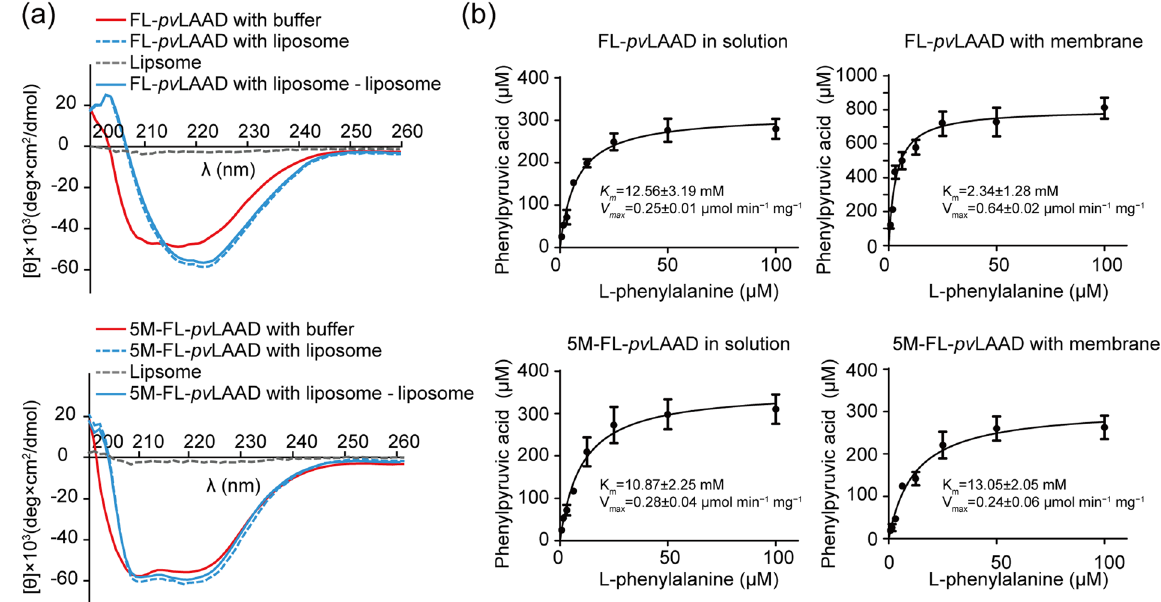
Figure 4. Membrane binding stabilized the structure of pv LAAD. ( a ) Liposome-binding-caused secondary structure changes of the wild-type and mutated pv LAAD were detected by CD. The CD spectra of FL- pv LAAD and 5M-FL- pv LAAD were recorded with or without adding the liposome. The CD spectrum of the liposome was also recorded (dashed line), and was subtracted as background from the spectra of pv LAADs with the liposome. An obvious bathochromic shift was observed between the CD spectra in solution (Red line) and with liposome (Blue line) of FL- pv LAAD. However, such bathochromic shift was less significant for 5M-FL- pv LAAD, suggesting the secondary structure reorganization was mainly caused by the INS-liposome interaction. ( b ) Enzymatic kinetic parameters of FL- pv LAAD and 5M-FL- pv LAAD with or without membrane presence were measured. In comparison with pv LAAD in the solution, membrane enhanced the substrate binding affinity ( K m ) for about 5.4 folds and substrate transformation rate ( V max ) for about 2.6 folds for wild-type pv LAAD. The enzymatic kinetic parameters of 5M-FL- pv LAAD were quite similar to those of wild-type pv LAAD in the solution, and they were not changed by adding the